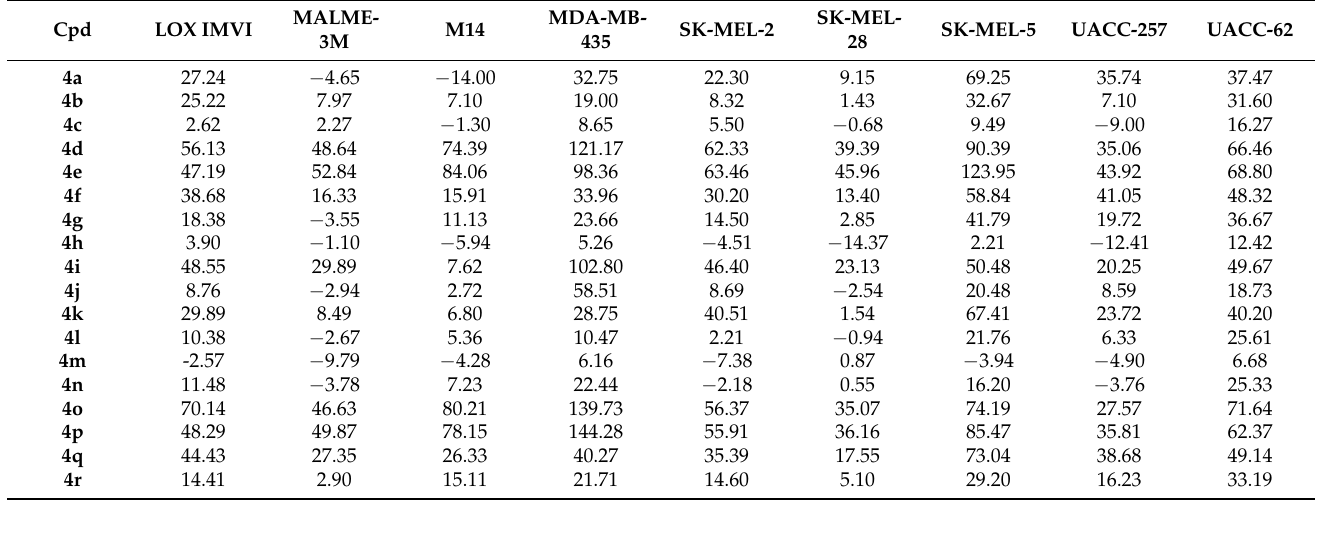
Table 9. Anti-proliferative activities (% growth inhibition) of the target compounds 4a – r against melanoma cell lines.